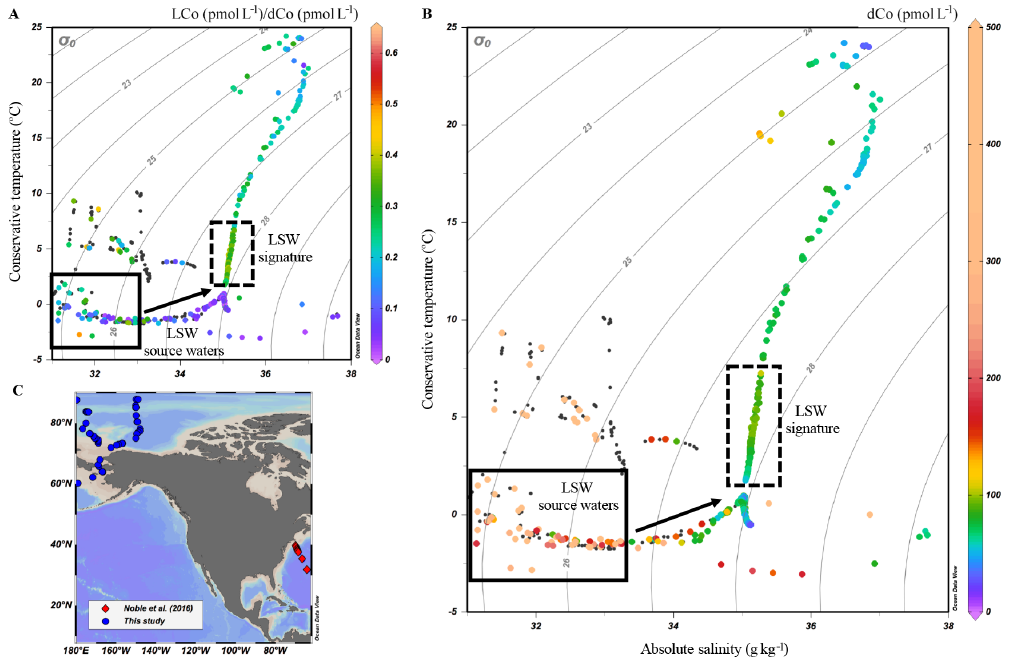
Figure 15. (a) The ratio of LCo to dCo (colors) from this study and the western portion of the GA03 North Atlantic transect (Noble et al., 2017) along with dCo concentrations (b) in temperature–salinity space, with Labrador Sea Water (LSW) source waters (solid black box) and signature in the Atlantic (dashed box) are highlighted. (c) Sampling region in this study and the stations used from Noble et al. (2017).